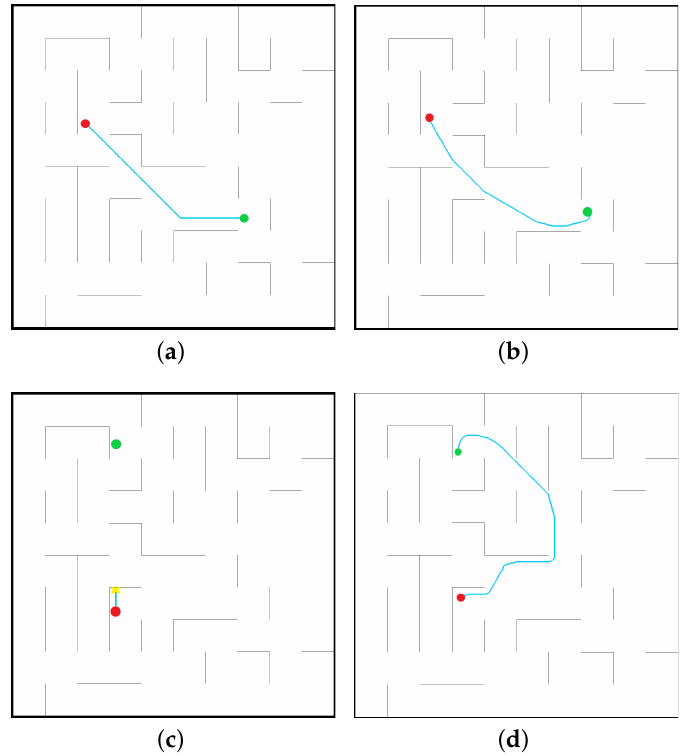
Figure 9. The paths of the mobile robot while performing navigation tasks using the trained neural network model in the simulator. ( a ) APF; ( b ) proposed; ( c ) APF; ( d )